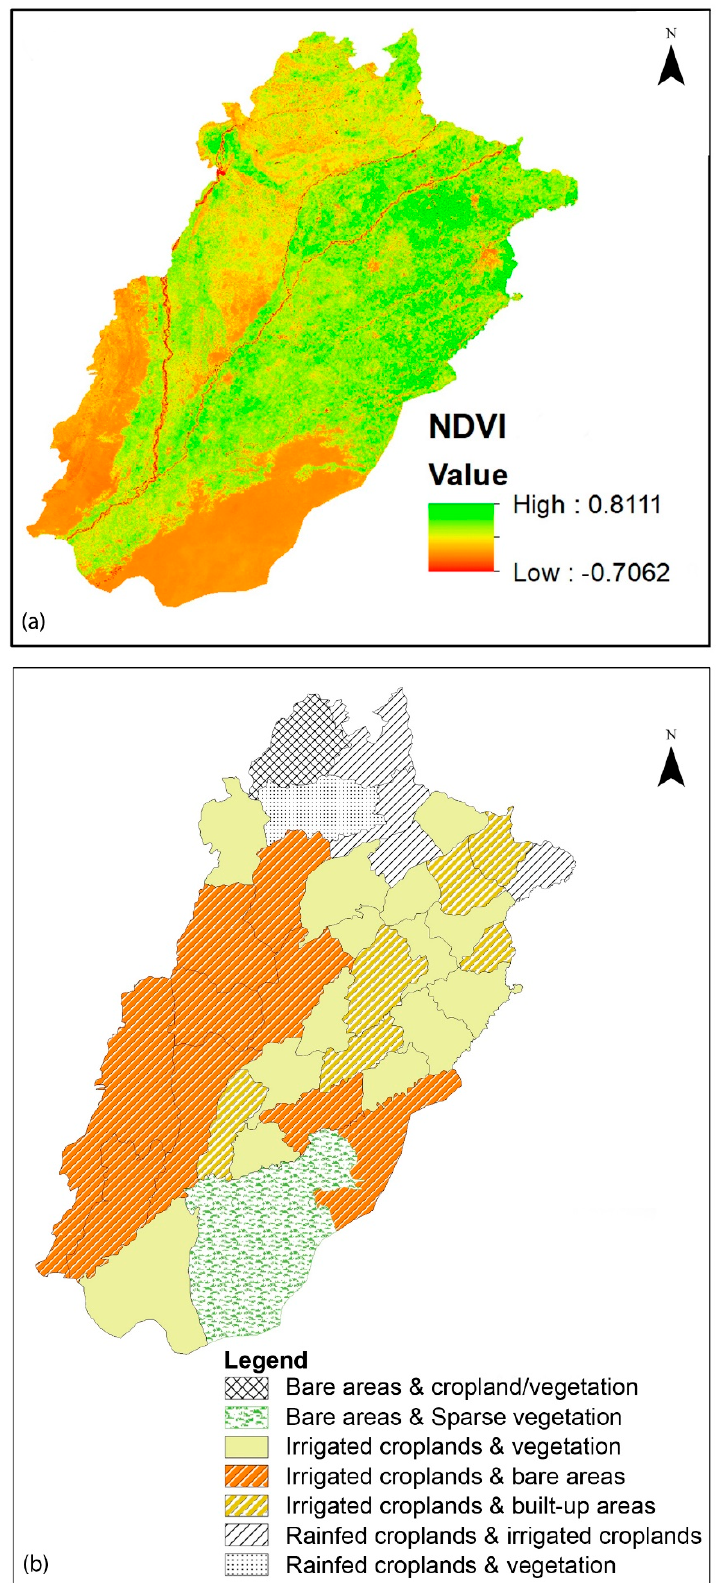
Figure A3. Maps of indicators belonging to land resources group (G3): ( a ) normalized difference vegetation index; ( b ) dominant landcover